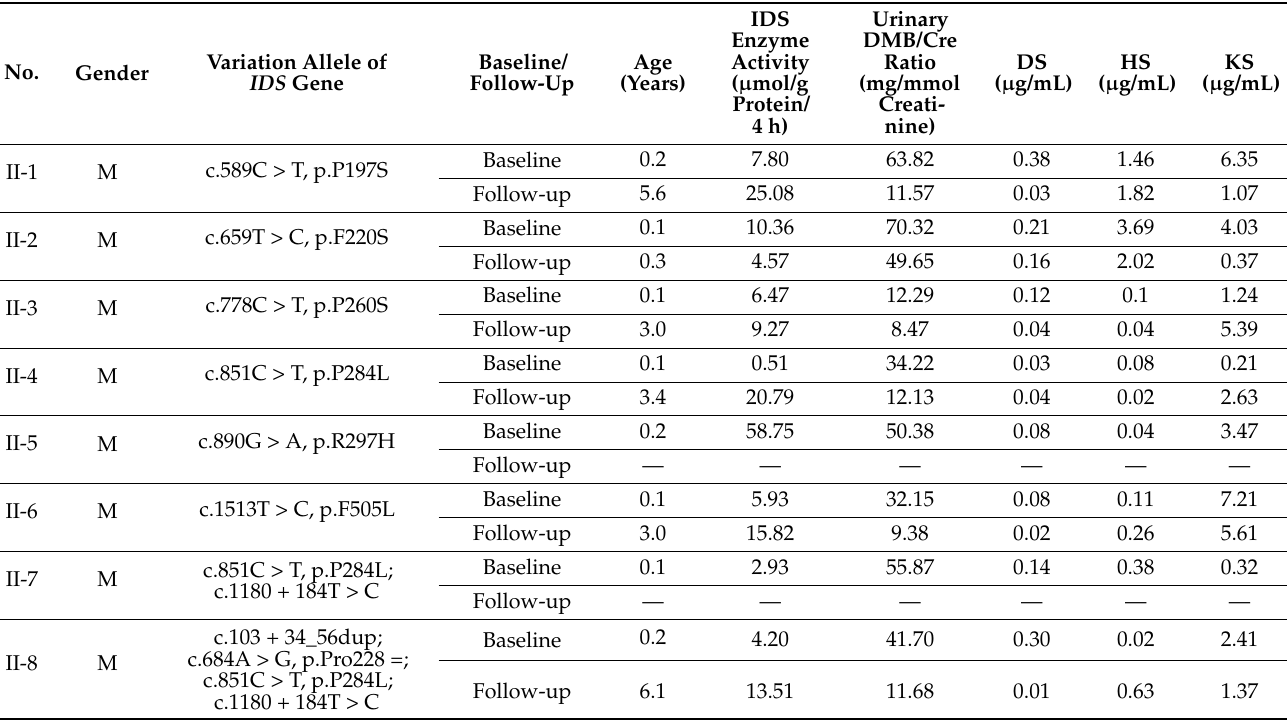
Table 3. The baseline and long-term follow-up data of Group 2 (suspected MPS II or pseudode- ficiency). We chose one subject of the longest follow-up time with each IDS gene variant as the representative